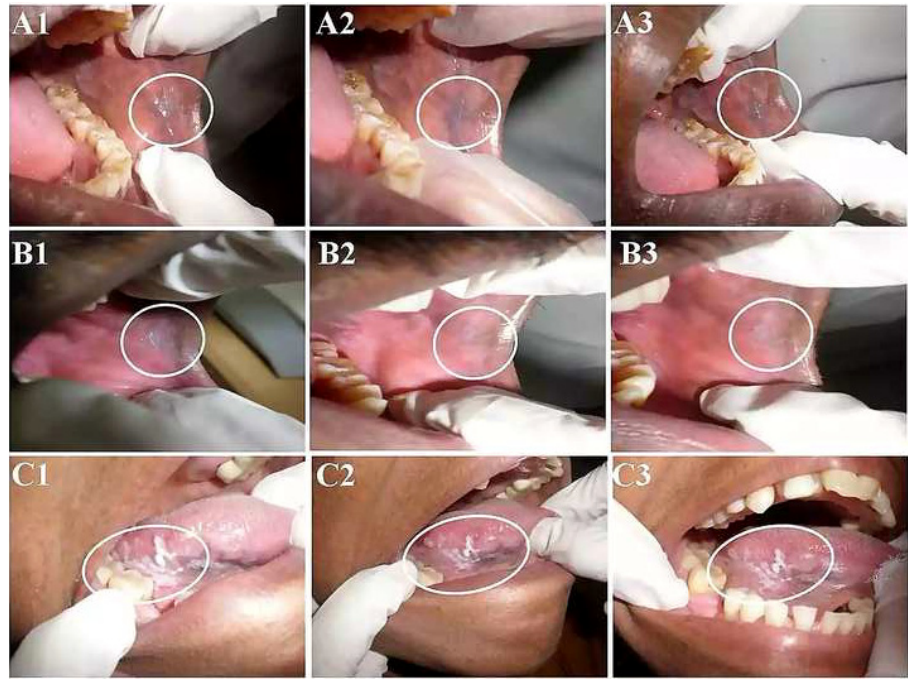
Fig. 5. Clinical photographs of OLP lesion (A1, B1, C1) before the treatment, (A2, B2, C2) and one week after the treatment and (A3, B3, C3) during follow-up,